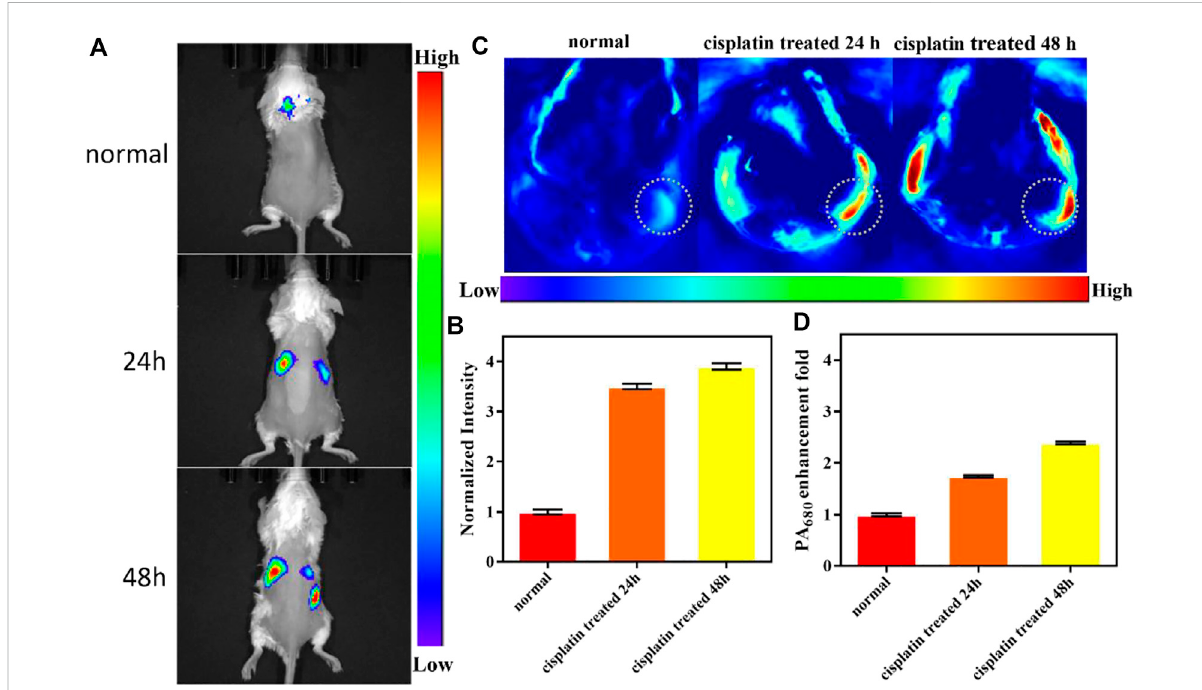
FIGURE 6 (A) In vivo imaging of a mouse after treatment with saline or cisplatin (20 mg/kg) for 24 h or 48 h, followed by injection (i.v.) of 0.15 mg/kg CS- ALP (in DMSO/DPBS, 1:4 v/v) for 20 min. Excitation fi lter 640, emission fi lter ICG. (B) Mean intensity ratio in (A) . (C) PA 680 nm images from the kidneys ofmice after pre-injection(i.p.)with salineorcisplatin(20 mg/kg)for 24 hor 48 h, followed byinjection (i.v.) of0.15 mg/kg CS-ALP (in DMSO/DPBS, 4:1 v/v) for 1 h. (D) Mean intensity ratio in (C) . Values are the mean ± SD, n =